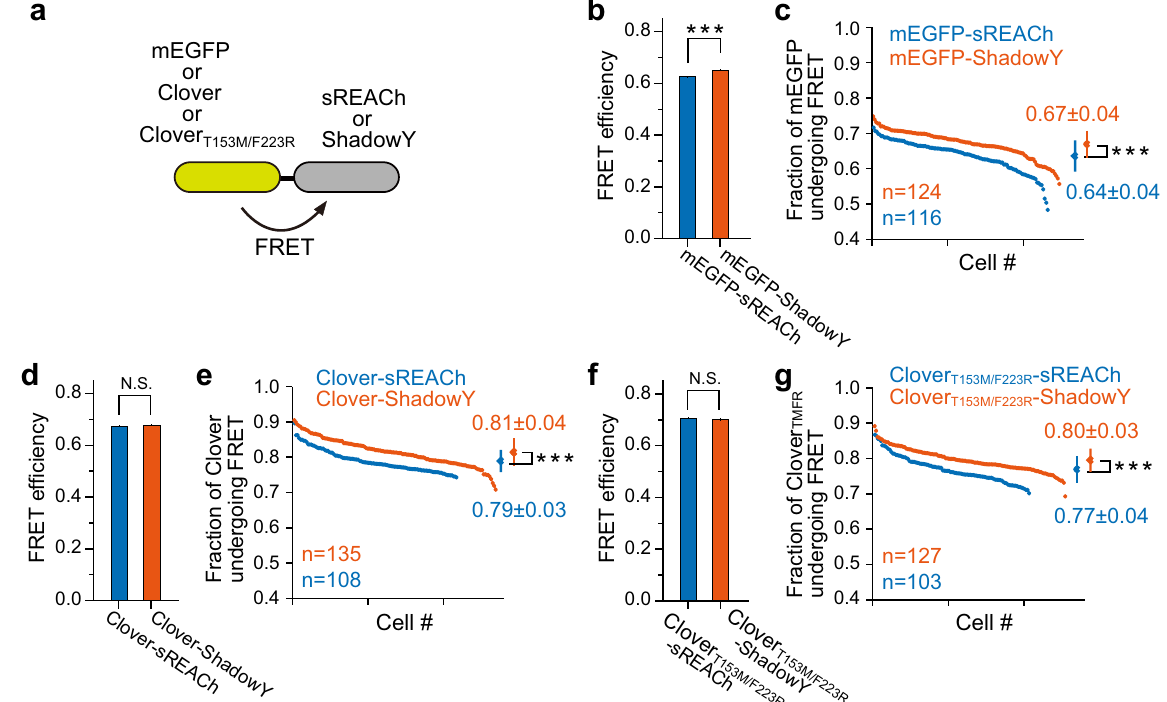
Figure 5. FRET efficiency and maturity of ShadowY in tandem fluorescent proteins. ( a ) A schematic drawing of the tandem fluorescent protein used to evaluate the FRET efficiency and fraction of the donor fluorescent protein undergoing FRET (chromophore maturation efficiency) for ShadowY. ( b , d , f ) Comparison of FRET efficiency of the tandem fluorescent proteins. The fluorescence lifetime decay curve averaged over the whole image was used for the analysis (See Materials and Methods ). The number of images used for the analysis is 10–13. Each image contains 8–15 cells, and the data are presented as mean ± SEM. Asterisks denote statistical significance ( t test, * P < 0.05, ** P < 0.01, *** P < 0.001, N.S. = not significant). ( c , e , g ) A comparison of the fraction of donor fluorescent protein undergoing FRET analyzed in individual cells and data was plotted in the descending order. The FRET fraction is directly related to the maturation efficiency of an acceptor, i.e., sREACh or ShadowY. Means ± SD are also plotted on the right ( t test, * P < 0.05, ** P < 0.01, *** P < 0.001, N.S. = not significant). The number of samples (n) and mean ± SD are also indicated in